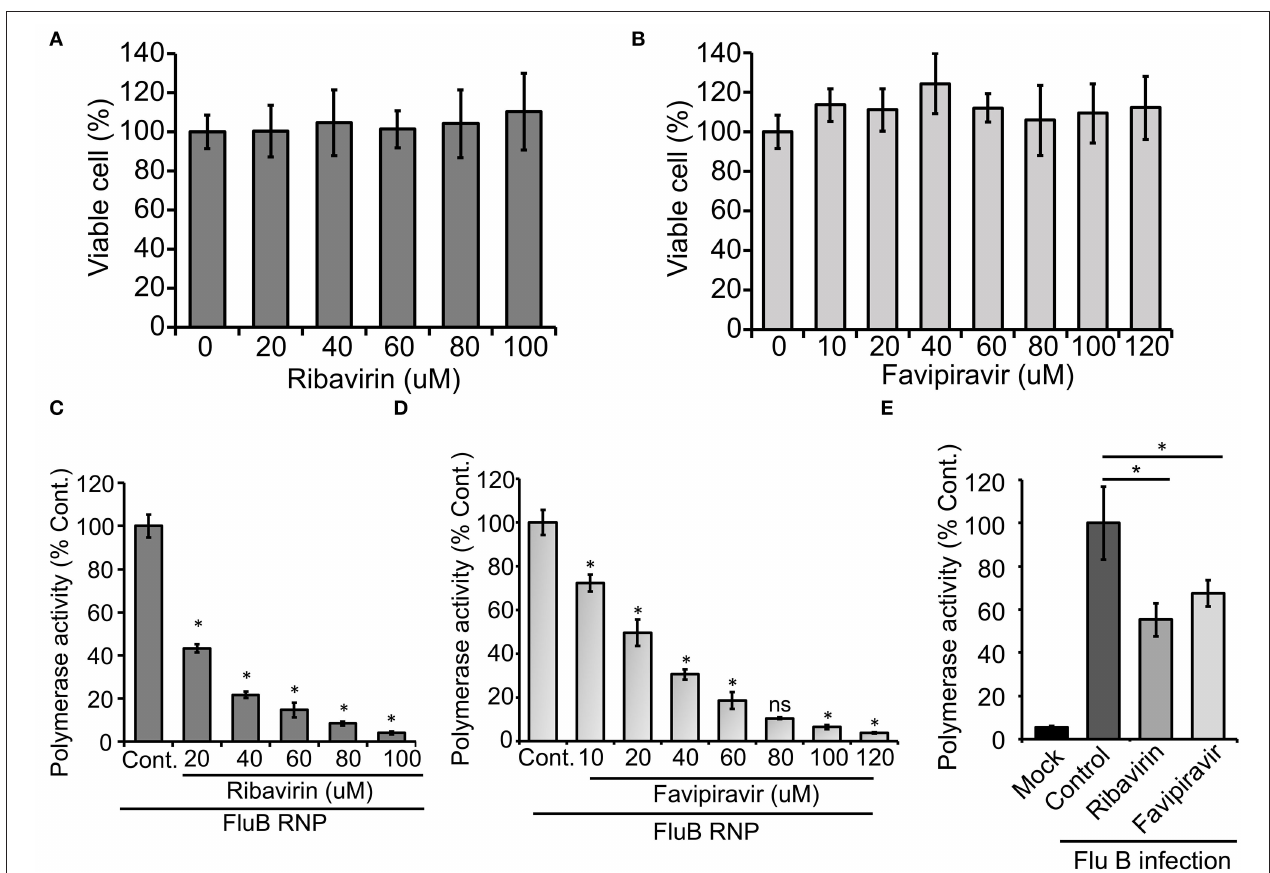
FIGURE 5 | An effect of antiviral drugs upon viral RNA synthesis in an infection-free and infection setting: (A,B) 3-(4,5-dimethylthiazol-2-yl)-2,5-diphenyltetrazolium bromide (MTT) assay to determine the cytotoxicity of Ribavirin and Favipiravir on HEK 293T cells. (C–E) The effect of Ribavirin and Favipiravir on influenza B virus RNP activity. Viral polymerase proteins in HEK 293T cells are expressed by transient transfection (C,D) or by infecting the cells with influenza B virus (E) ( n = 3 ± SD, * p < 0.05 one-way ANOVA with post-hoc Student’s t -test when compared to the preceding set, for (E) , comparison was performed with control set, ns, not